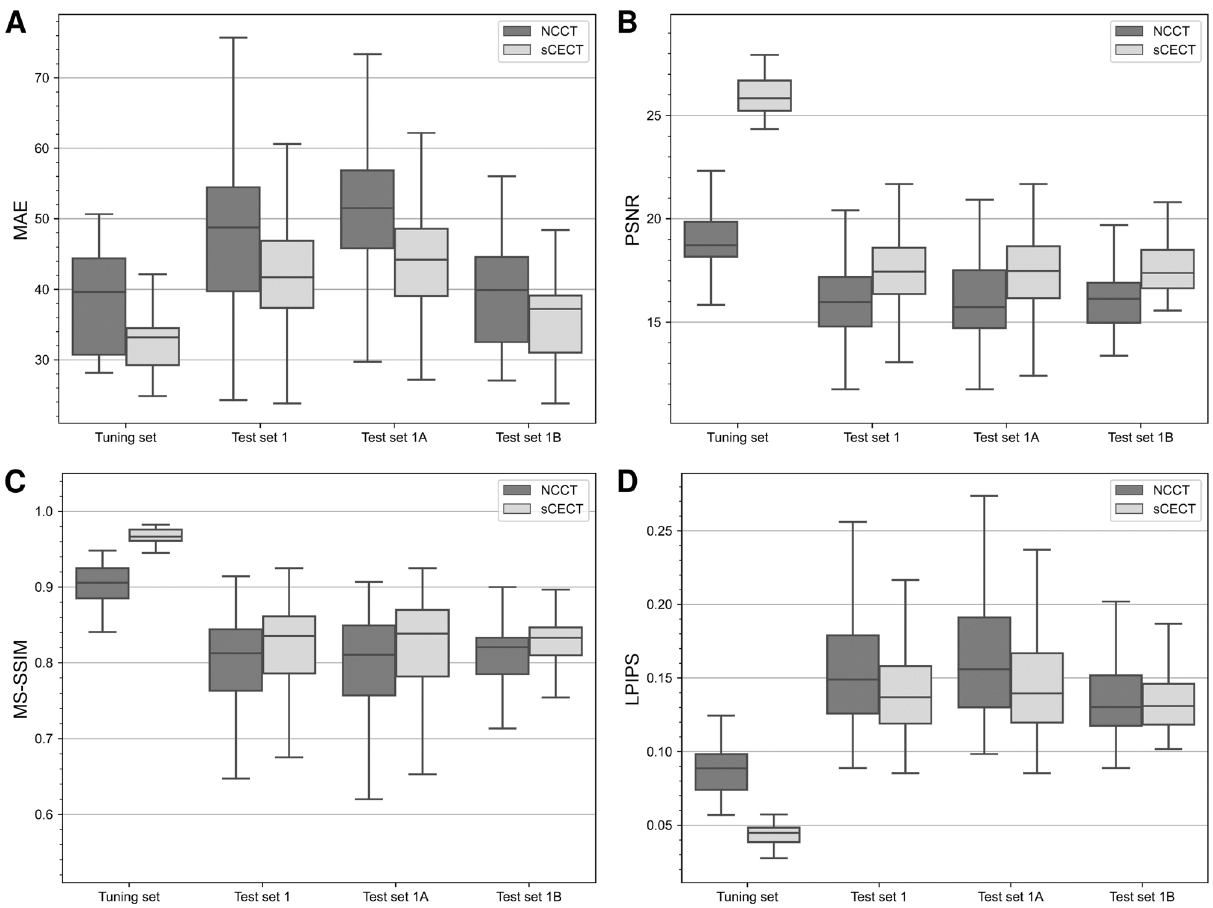
Figure 4. Comparison of image similarity metrics between non-contrast CT (NCCT) and synthetic contrast- enhanced CT (sCECT) with contrast-enhanced CT as the ground truth. Mean absolute error (MAE) ( A ), peak signal-to-noise ratio (PSNR) ( B ), multiscale structural similarity index measurement (MS-SSIM) ( C ), and learned perceptual image patch similarity metric (LPIPS) ( D ). Lower MAE, higher PSNR, higher MS-SSIM, and lower LPIPS values indicate higher image similarity. All comparisons showed significant differences ( P < 0.05).